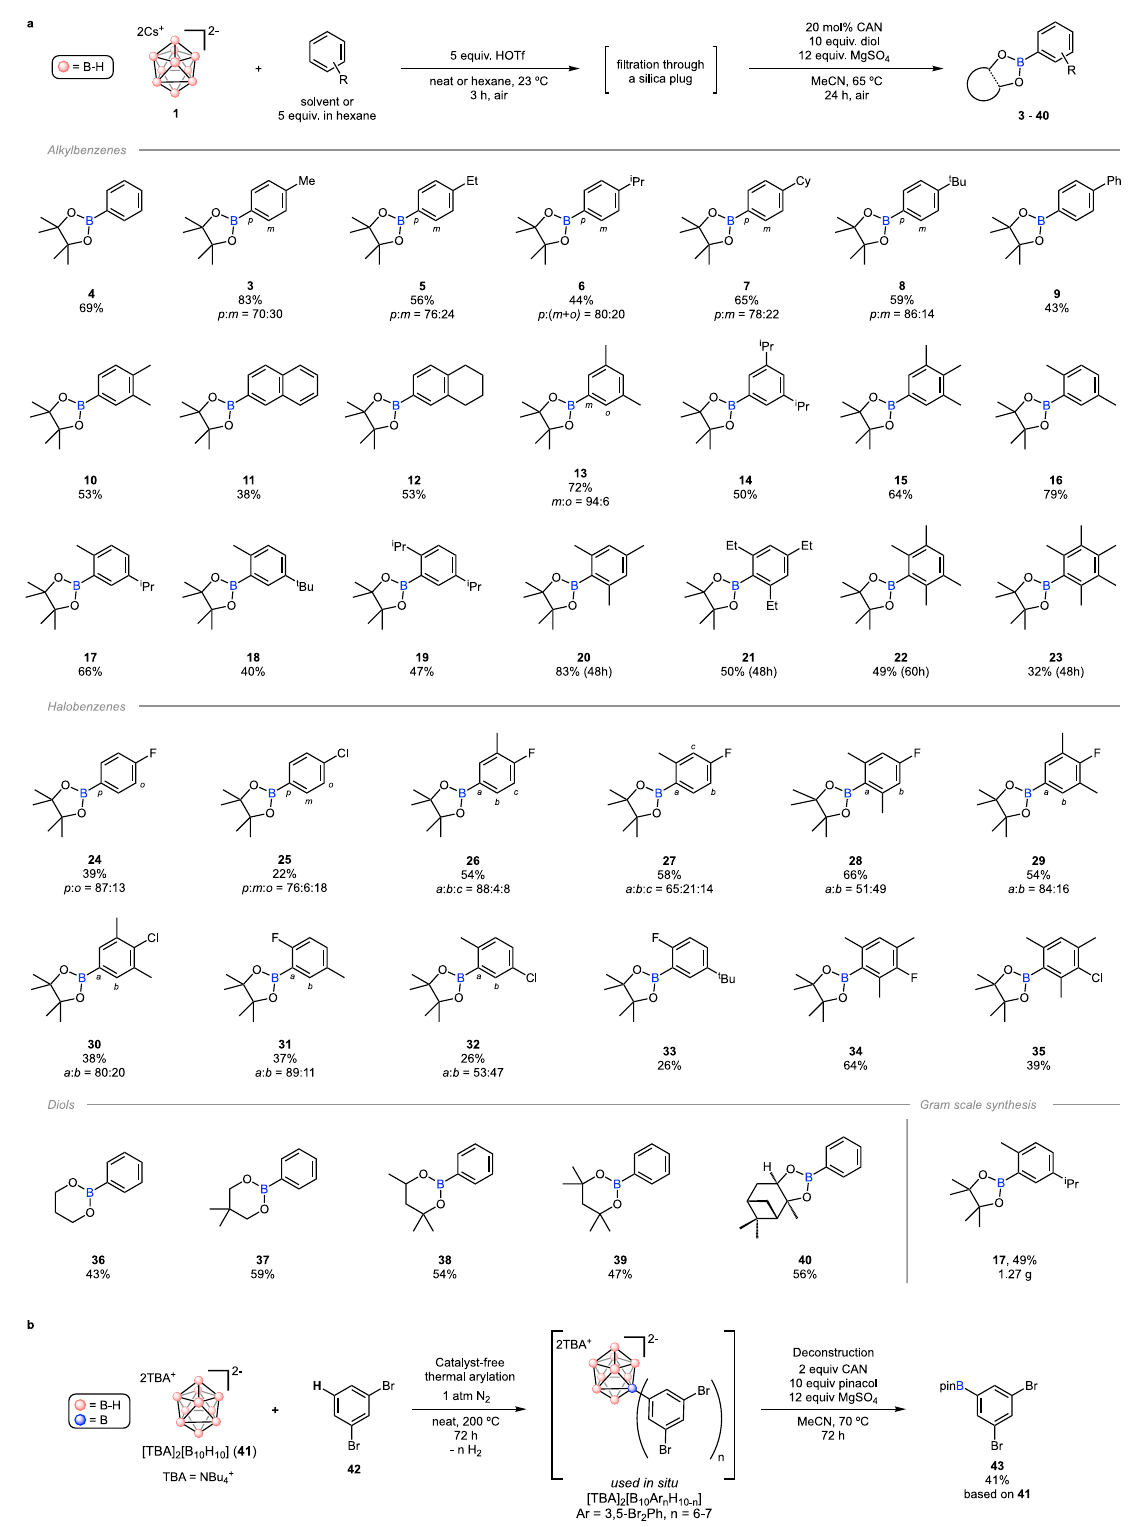
Fig. 3 | Substrate scopes. a Substrate scopes of the boron cluster-mediated arene C – H borylation. Longer reaction times in the deconstruction step are shown in parentheses. b Alternative strategy to borylate a highly electrophilic 1,3-dibromobenzene using [B 10 H 10 ] 2 – as the boron